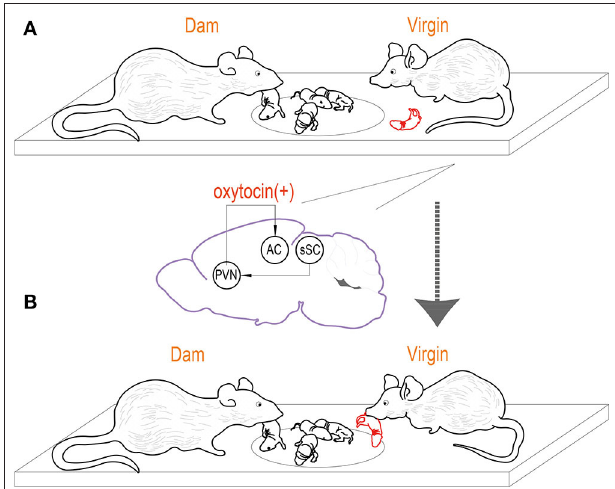
FIGURE 1 | Virgin mice can learn how to raise and retrieve pups by observing. (A) PVN to auditory cortex projections modulated by oxytocin is necessary for the learning of pup retrieval. In virgins that begin retrieving, PVN to auditory cortex projections are activated during observation of dam retrieval, on the contrary, they are not significantly activated in virgins that did not learn after observation. (B) The virgin mouse start to take parenting task after observing reproductive behavior of co-housed